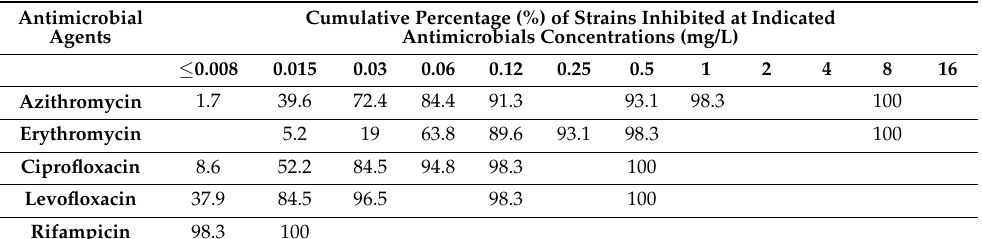
Table 1. Cumulative MICs (mg/L) distribution of 58 environmental isolates of Legionella pneumophila . Antimicrobial Agents